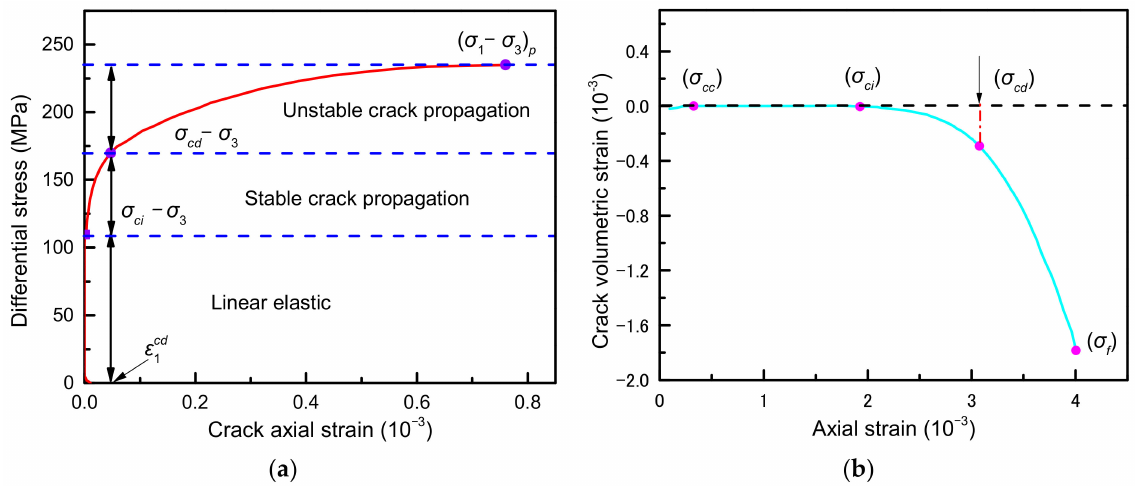
Figure 3. Prepeak crack strain trend of typical granites under confining pressure (10 MPa): ( a ) the differential stress–axial crack strain curve; ( b ) the axial strain–volume crack strain